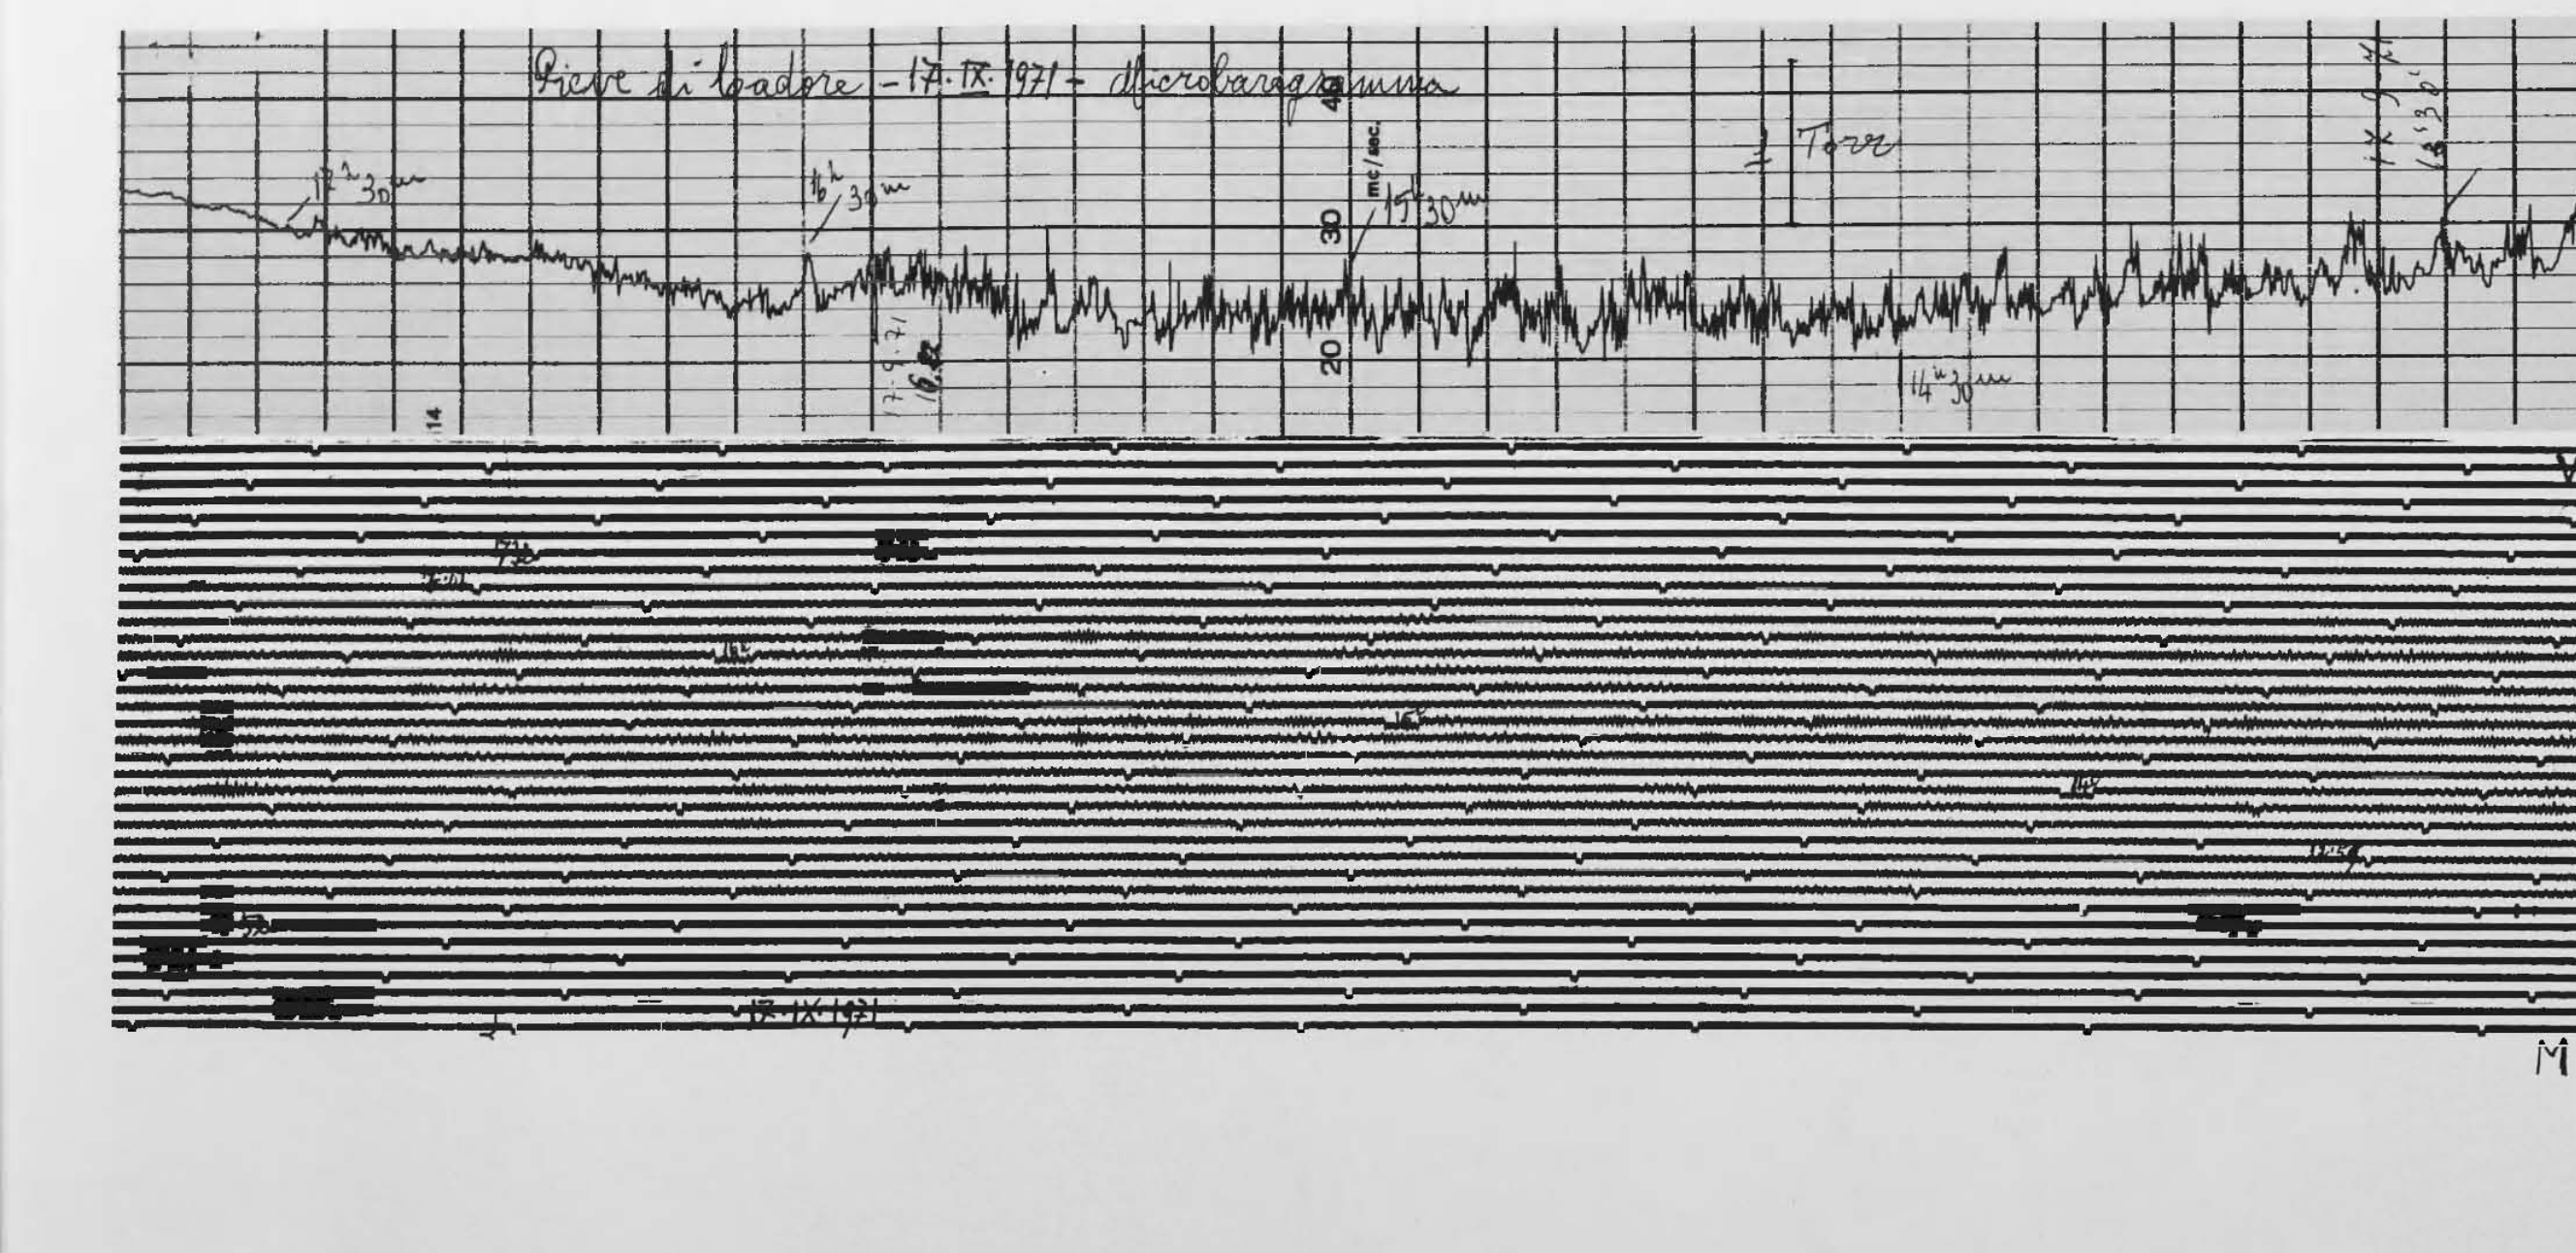
Fig. 18 A volte, le rapide fluttuazioni della pressione e, quindi, i miero sismi da esse destati durano giornate (come quelle, che qui non si ripOl'tllllo, presenti dalle 9 h del 15 alle 71115m del 16.IX.1971). L'esempio sopra riportato è caratteristico: cOllie sempre, l'andamento dei microsismi segue l'andamento delle rapide fluttuazioni dell'atmosfera, e si attenuano con l'attenuarlli tli queste. Fig. 18 The quick pr6l!~lIre oscillatiolls, and hence the microseismic causetl by them, extend sometimes over entire day", (suell a~ the ones not represented here which lasted from 9" a.m. 01 Sept. l5 to 7 h l5 m a.lll. of Sept. l6, 1971). The above quoted example is typical: al! IIsllal, the course of microseillms follows the course of quick atmosphere oBcillations, and they diminish as the latter